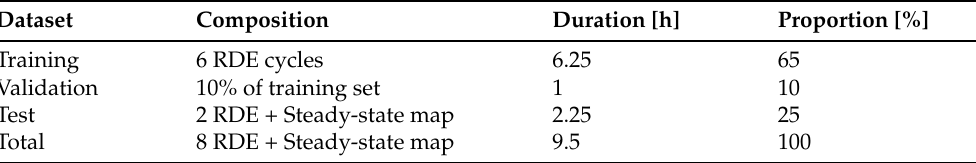
Table 3. Dataset